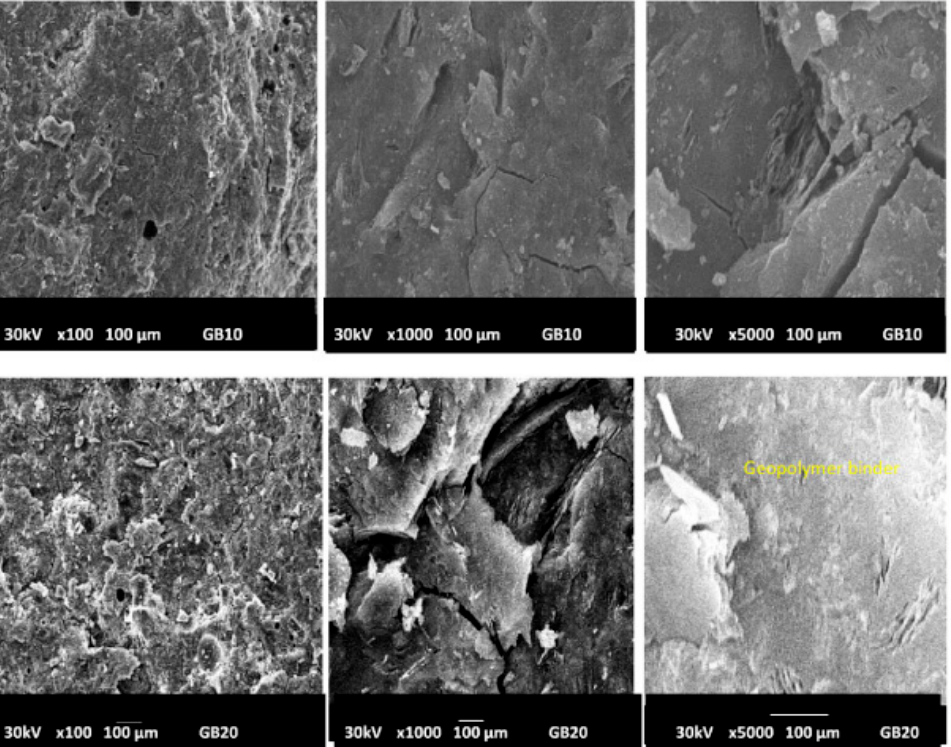
Figure 12. Micrograph images of geopolymer materials with the addition of magnetite (GB10, GB20) with magnifications x100, x1000, x5000 (from left to right ).